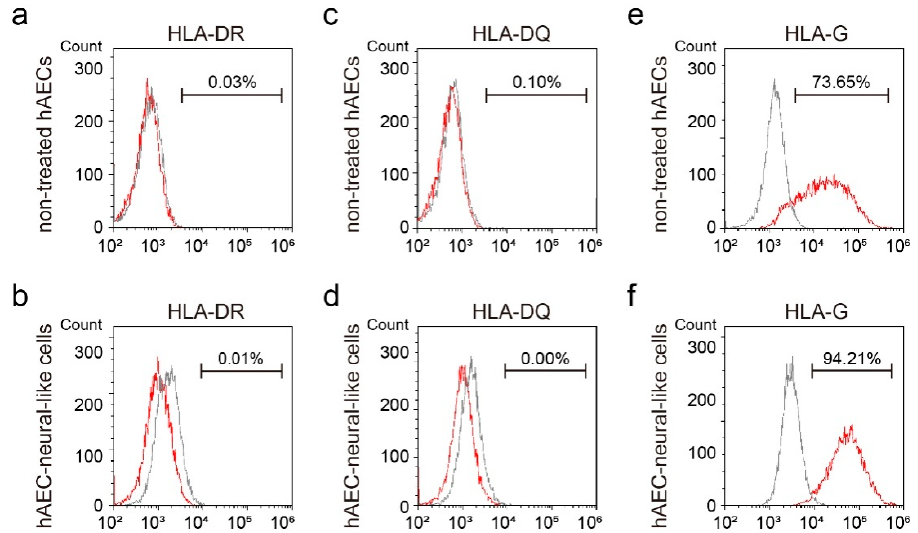
Figure 3. The immunogenic characteristics of hAEC-neural-like cells induced by the BGVB ap- proach. ( a – d ) The flow cytometry results of HLA II antigens of hAECs and hAEC-neural-like cells. ( e , f ) The flow cytometry results of non-classical HLA I antigens (HLA-G) of hAECs and hAEC-neural-like cells.